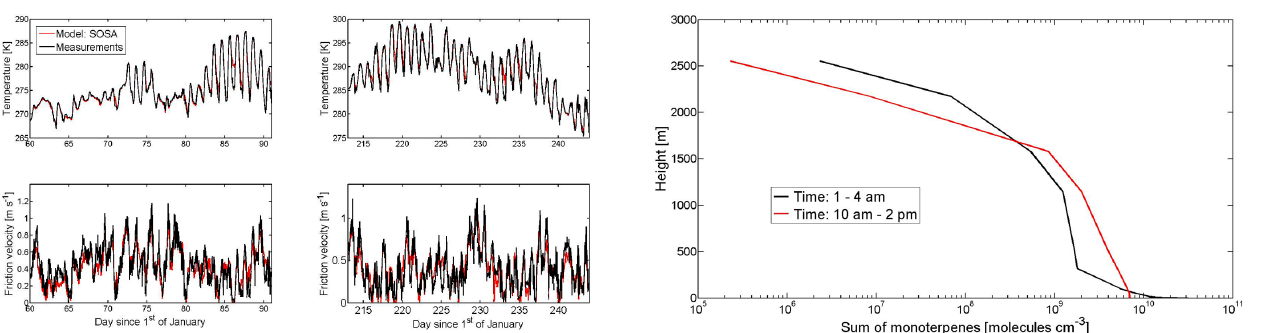
Fig. 5. Averaged vertical profiles of the sum of monoterpenes for the period from 1 to 26 June 2007 at two different time